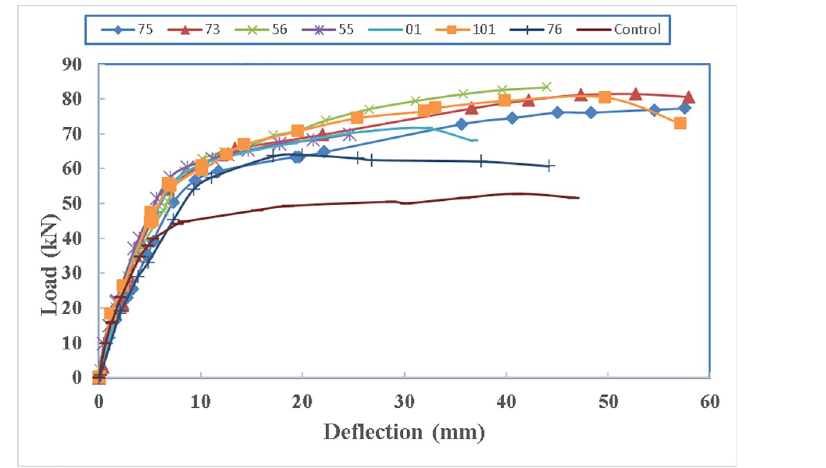
Fig 16. Load- deflection diagram of the beams.